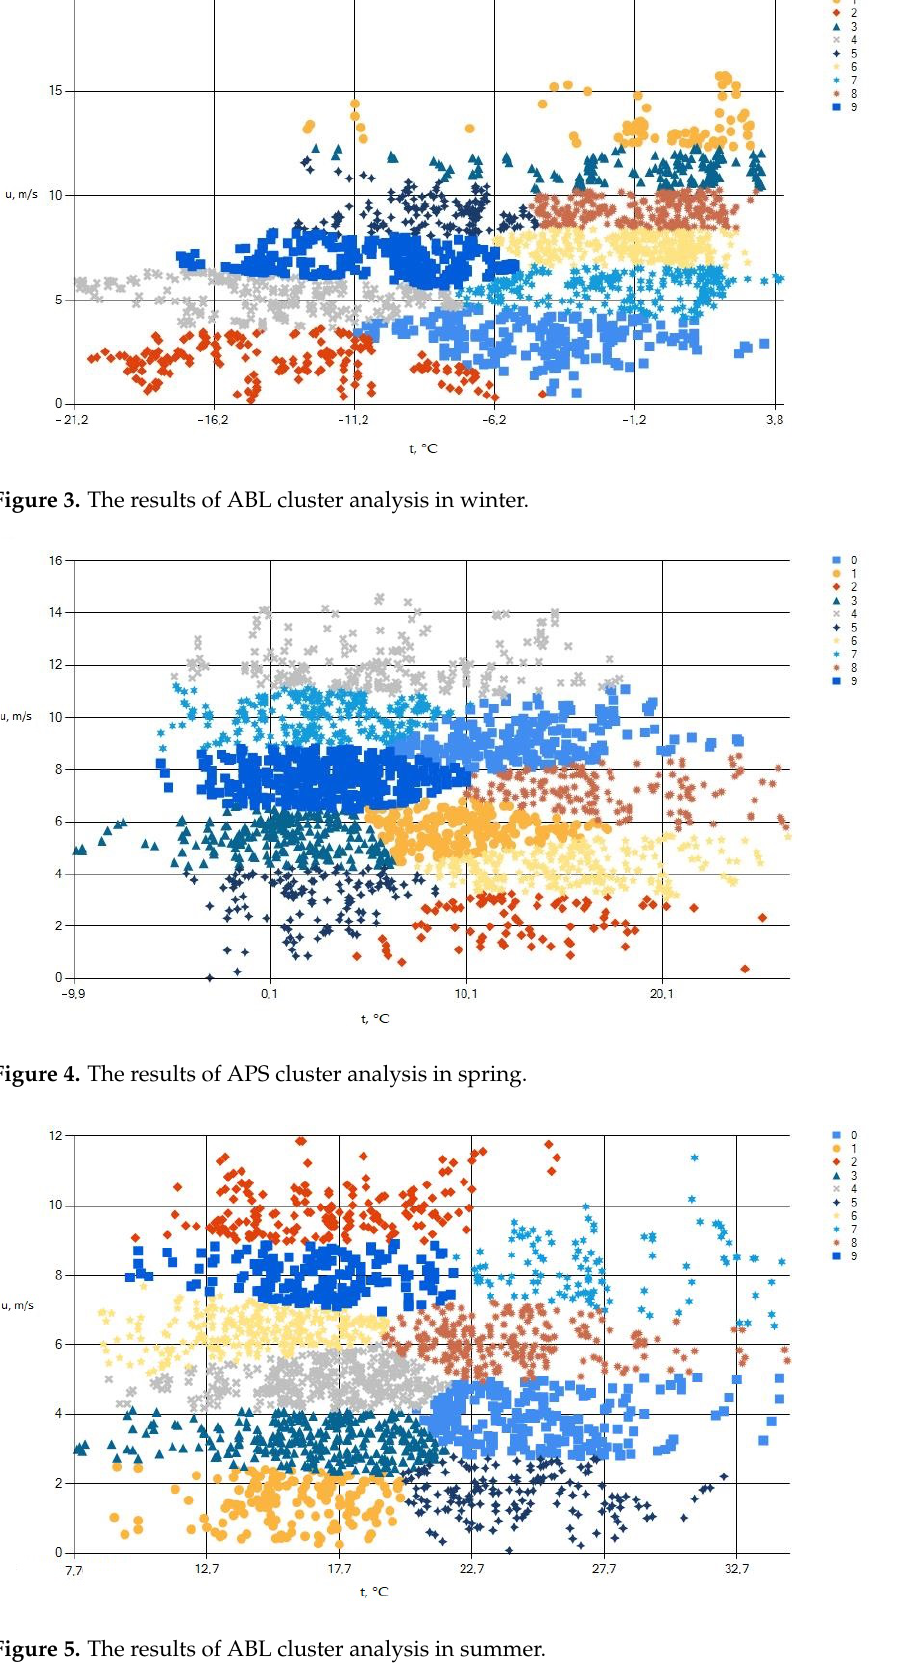
Figure 5. The results of ABL cluster analysis in